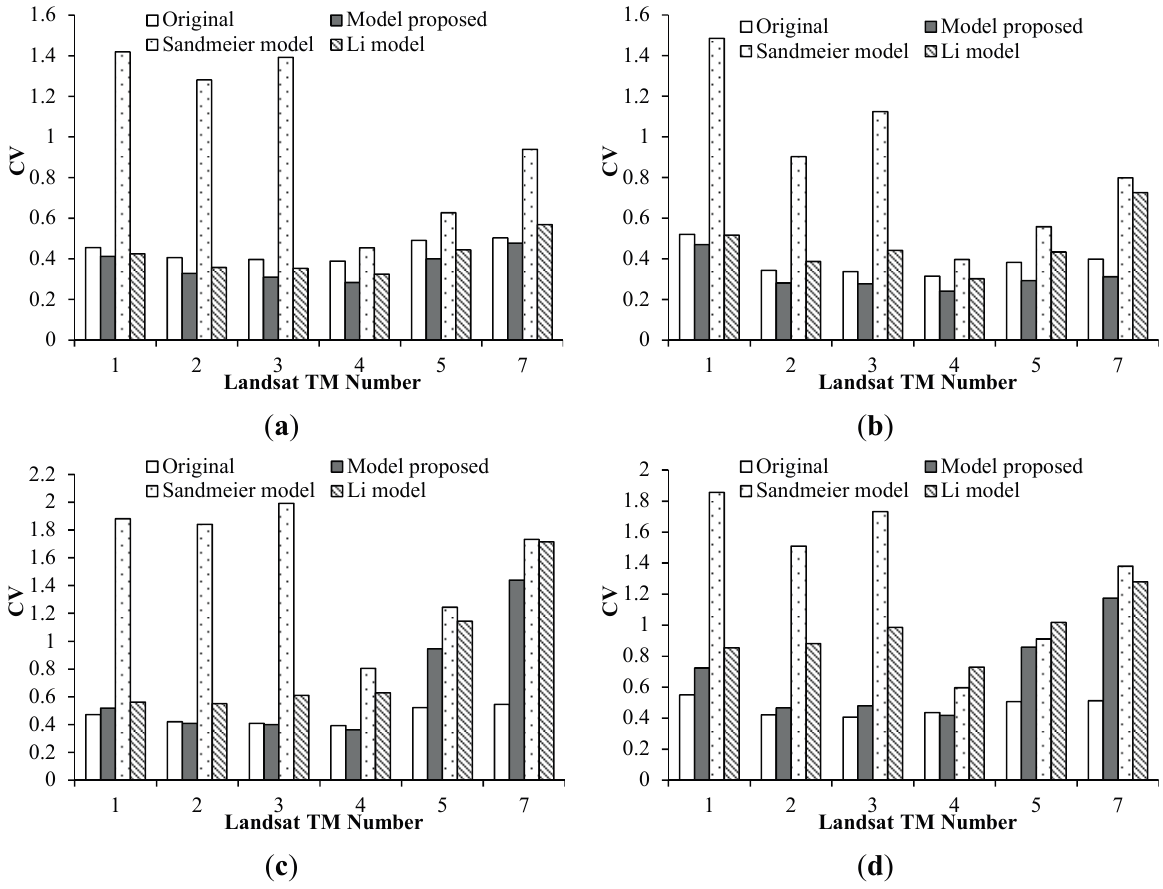
Figure 6. Coefficients of variance of forest pixels for each band before and after topographic correction by different models; ( a ) is for non-shadow forest of spring TM scene; ( b ) for non-shadow forest of autumn TM scene; ( c ) for shadow forest of spring TM scene; and ( d ) for shadow forest of autumn TM